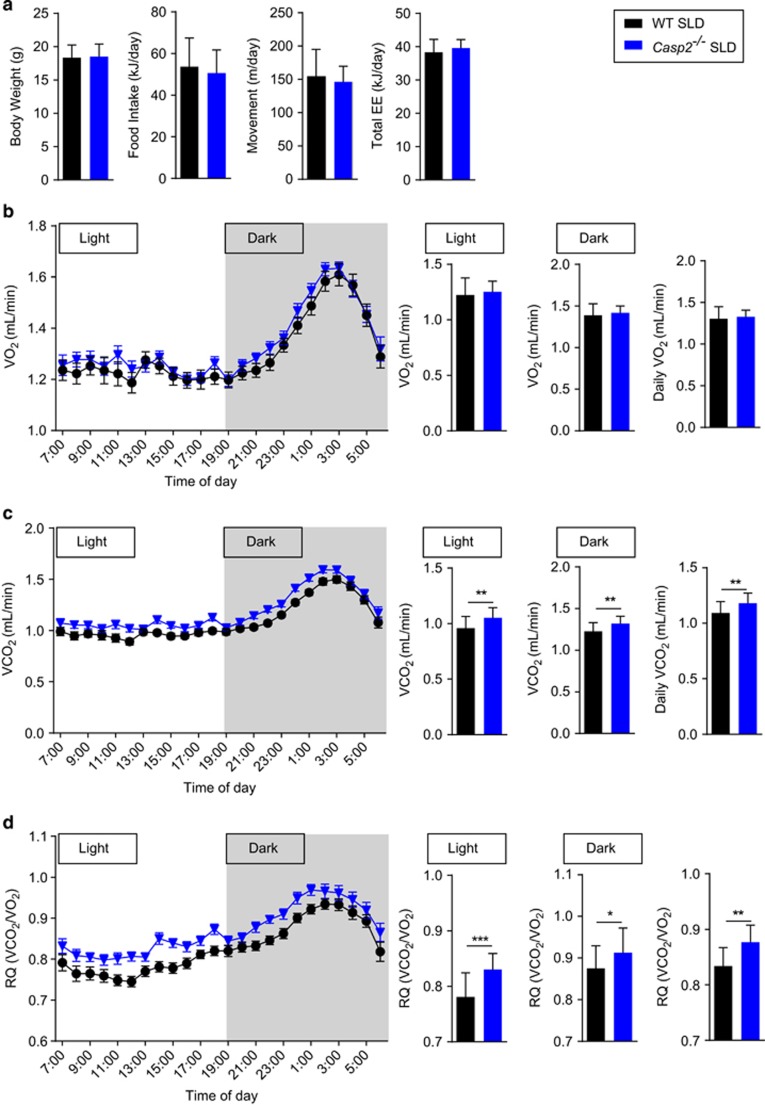
Caspase-2 deficiency shifts whole-body fuel utilisation in SLD-fed mice. Metabolic monitoring with indirect calorimetry performed on 4-week old WT and Casp2−/− mice after 1 week of ad libitum SLD-feeding. (a) Body weight, total daily food intake, activity (movement) and energy expenditure (EE). (b) VO2 consumption (c) VCO2 carbon-dioxide production and (d) RQ determined over 24- h period with 12-h light–dark cycles. Values are means±S.D. (bar graphs) and means±S.E.M (scatter plots) (n=22–23 per group). Statistical significance indicated as *P<0.05, **P<0.01, ***P<0.001